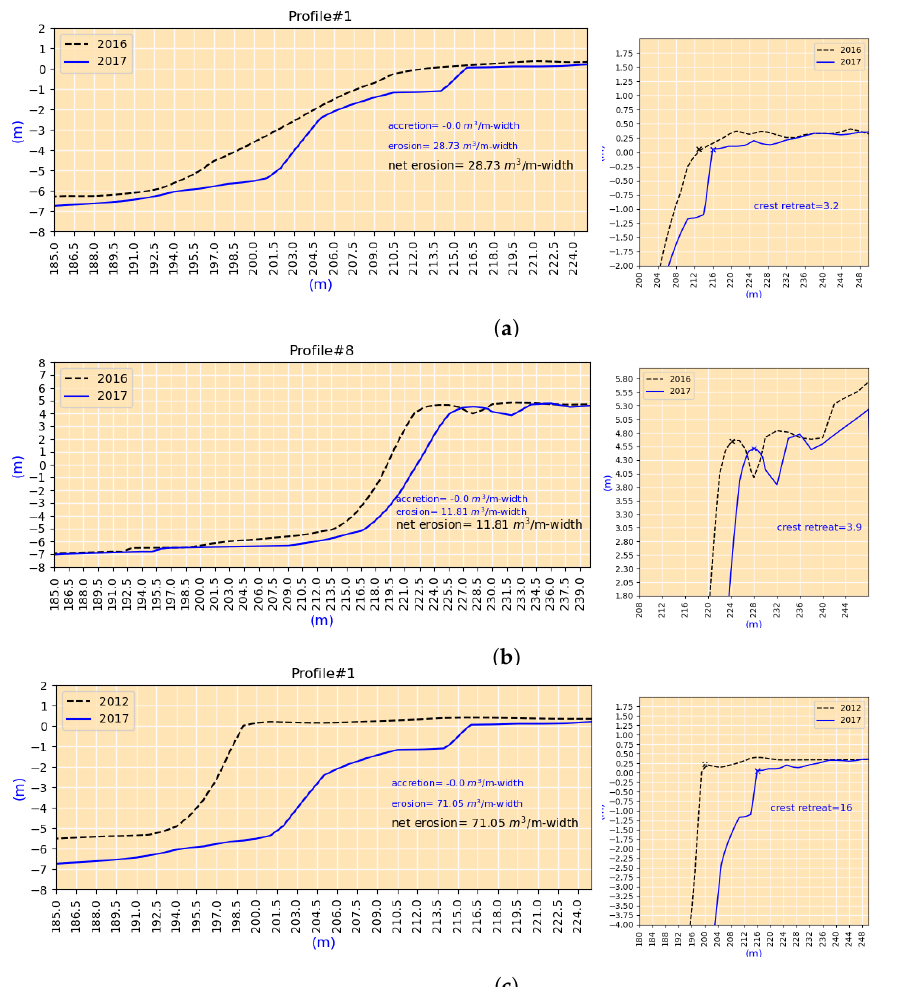
Figure A8. Coastal profiles of cases#3, #4 and #5 are shown. ( a ) Case#3: Measurements are of profile P#1, from 2016 to 2017. ( b ) Case#4: Measurement of profile P#8, from 2016 to 2017. ( c ) Case#5: Measurement of profile P#1, from 2012 to